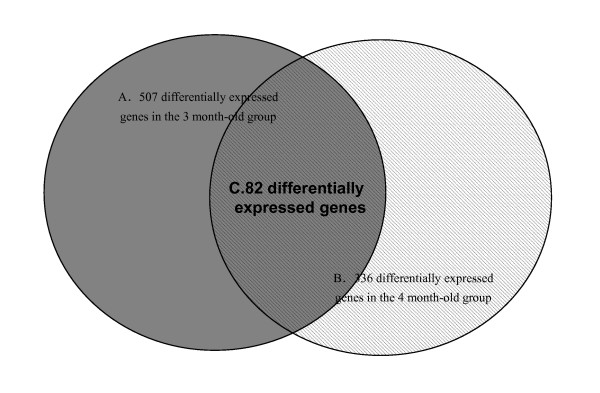
82 genes were differentially expressed in the DNA microarray analysis in pig fat tissue with clenbuterol administration (P < .05) in both groups. A. The black circle indicates the 507 differentially expressed genes in the 3 month-old group (P < .05 in four microarray slides). B. The cross-hatched circle indicates the 336 differentially expressed genes in the 4 month-old group (P < .05 in four microarray slides). C. The overlapping region indicates the 82 differentially expressed genes in both the 3 month old group and the 4 month old group that were of interest.